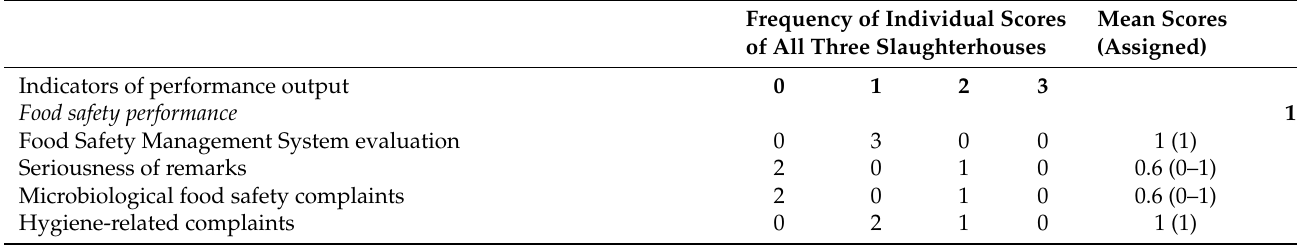
Table 3. The food safety performance of the slaughterhouses.